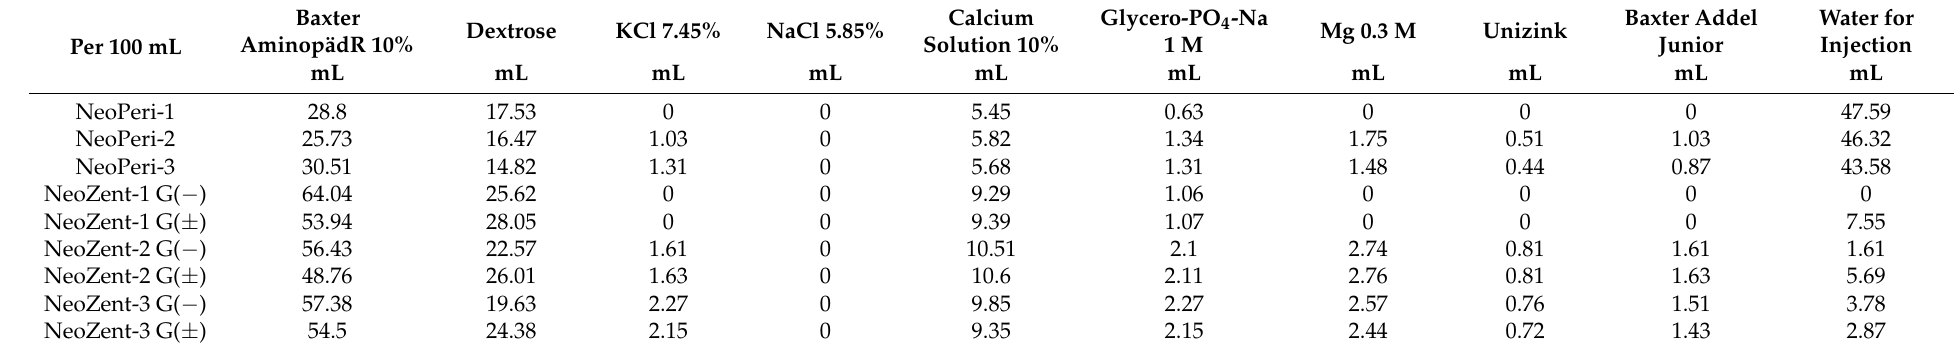
Table 3. ‘NeoPeri’ and ‘NeoZent’ solutions containing amino acids, glucose, electrolytes, and trace elements, supply per 100 mL